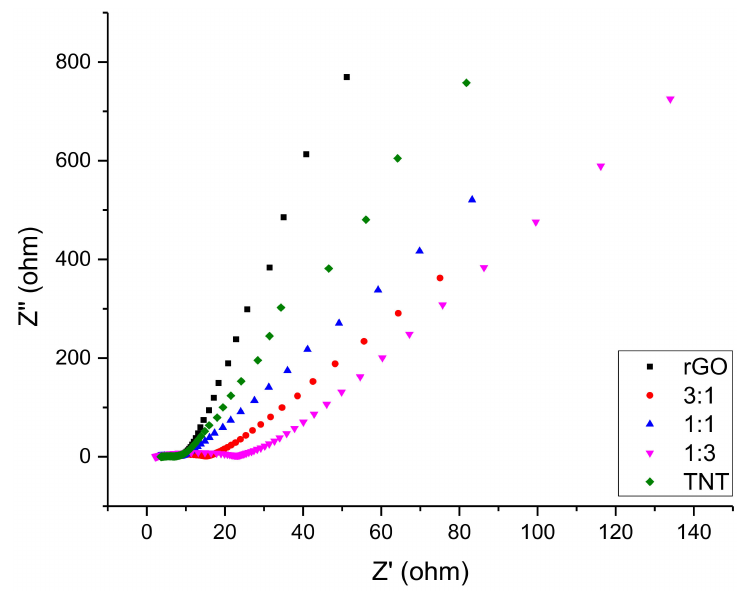
Figure 10. EIS of rGO/TiO 2 composites.